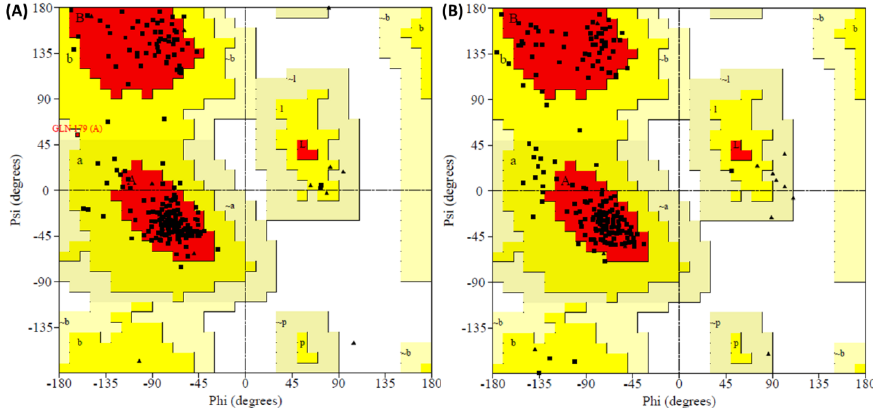
Figure 7. Ramachandran plot ( A ) I-19 -capsid complex; ( B ) PF-74 -capsid complex.